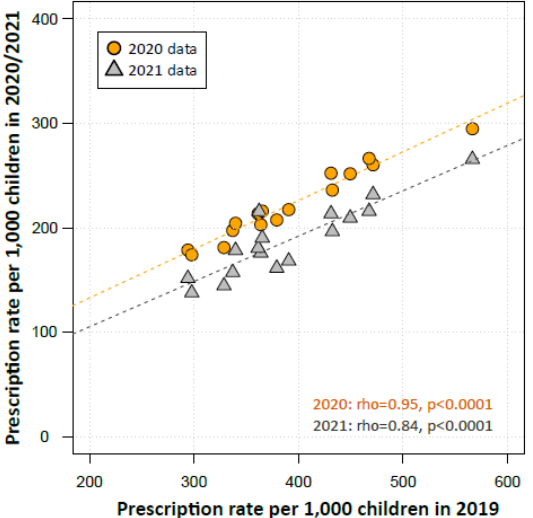
Figure 3. Scatter plot depicting the antibiotic prescription rates in regions in 2019 over its rates in 2020 and 2021. Regions are represented by the regional Associations of Statutory Health Insurance Physicians (ASHIP, n = 17). The Spearman’s rank correlation coefficient (rho) was used to examine the relationship of the prescription rates in regional ASHIPS from the years 2019 and 2020/2021.